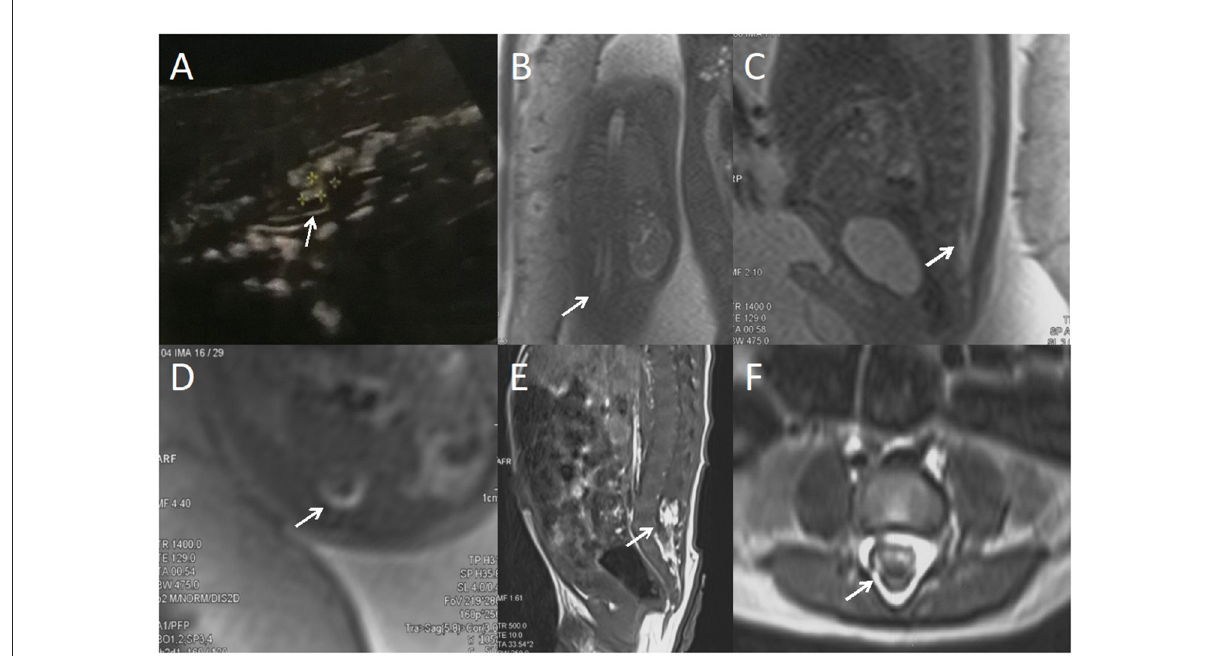
FIGURE1 A fetus with intraspinal lipoma. (A) the prenatal ultrasound examination at 24 weeks of gestation showed the presence of low conus medullosus in the fetus, hyperechoic mass shadow in the spinal canal, and broken spinal continuity. Thus, spina bifida and intraspinal lipoma were considered. (B) Fetal magnetic resonance imaging (MRI) examination at 24 + 2 weeks of gestation showed a coronal view of the low conus medullosus of the fetus, with enlarged end of the conus medullosus and tight adhesion to the posterior edge of the spinal canal. (C) Sagittal view showed the low conus of fetal myeloma cord. (D) In the axial position, normal subarachnoid space in the spinal canal disappeared, with lipoma and spinal nerves mixed. (E) T1 sagittal MRI of the lumbosacral vertebrae 10 days after birth suggested intraspinal lipoma. (F) Axial MRI of the lumbosacral vertebrae showed uneven internal signal of lipoma, which was considered to be a hybrid lipoma with the spinal nerves.